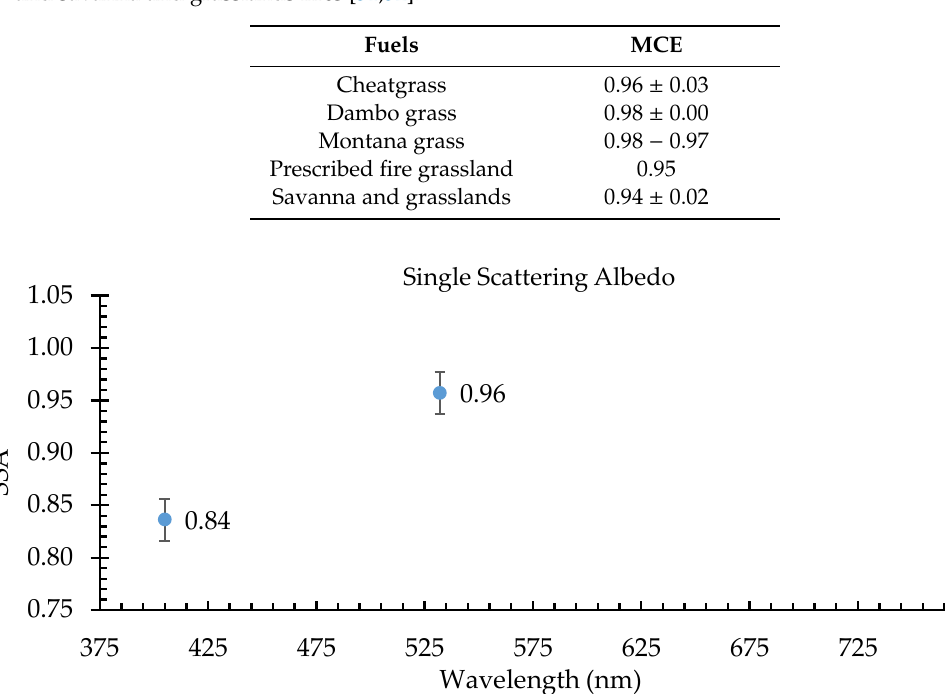
Table 1. Cheatgrass modified combustion efficiency (MCE) is shown with previously reported MCE values for a prescribed grassland fire [50], open laboratory combustion of Dambo and Montana grass [7], and savanna and grasslands fires [51,52]. Fuels